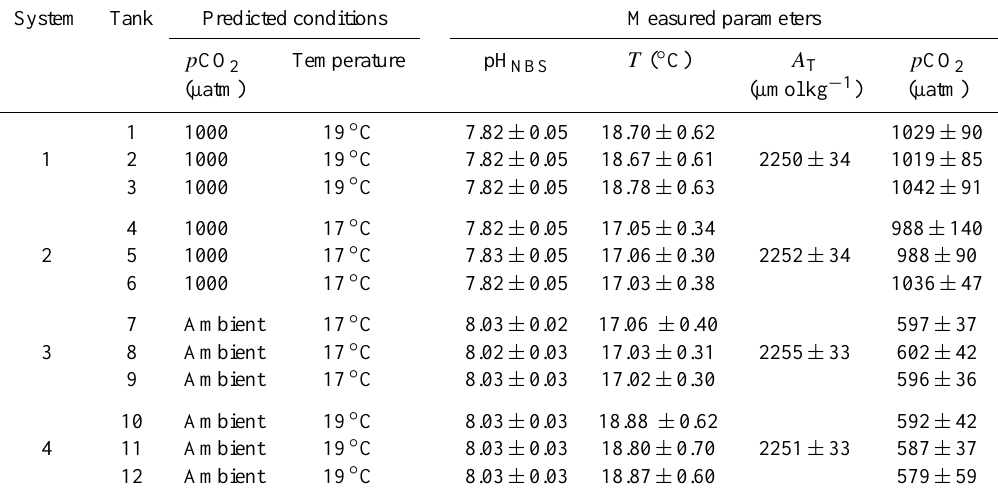
Table 1. Experimental conditions for the duration of the experiment (75d). Temperature and pH NBS are calculated from daily measurements in the experimental tanks once they had ramped to the desired conditions and as long as they contained animals ( N = 41–67). Total alkalinity ( A T ), which was used to calculate the p CO 2 values, was measured in the header tanks less frequently (typically twice a week but less frequently as the experiment progressed, N =9–11). Mean values ±